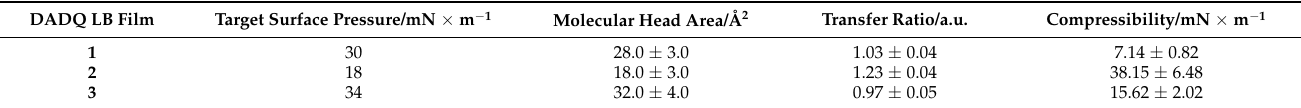
Table 1. Data obtained from the analysis of the LB isotherm experiments and parameters used in the LB film deposition. Transfer ratios were calculated for the 2nd layer. See text for